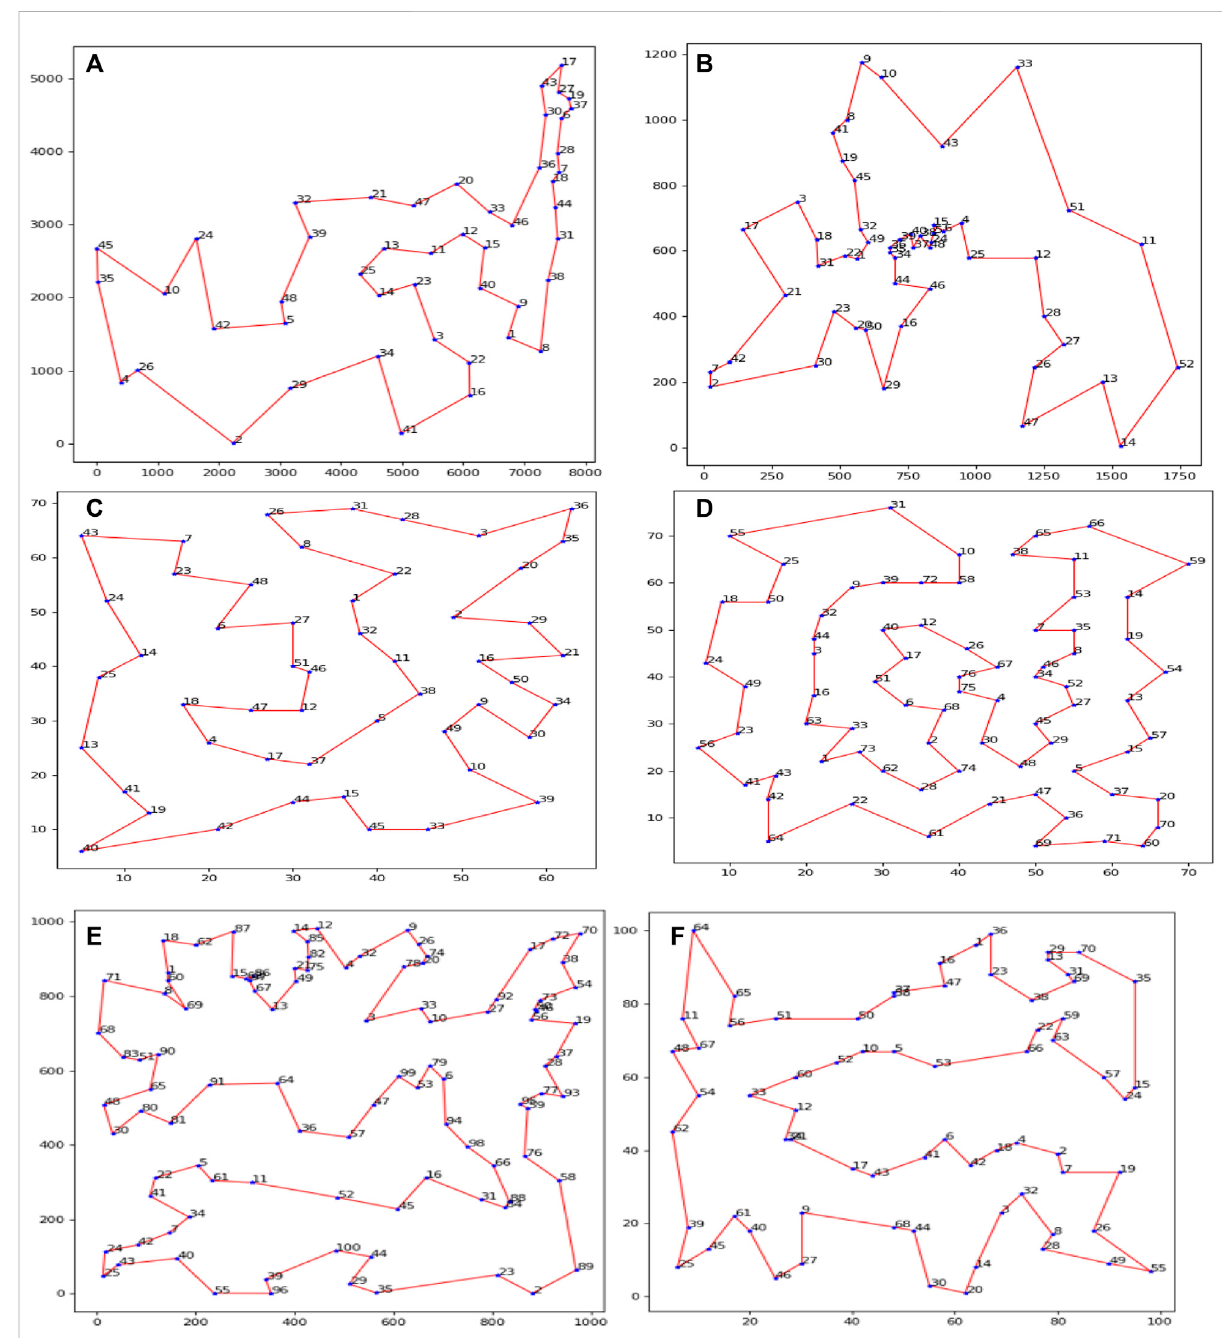
FIGURE 2 Some of the best routes generated by our algorithm (A) Att48, (B) Berlin52, (C) Eil51, (D) Eil76, (E) Rd100, (F)